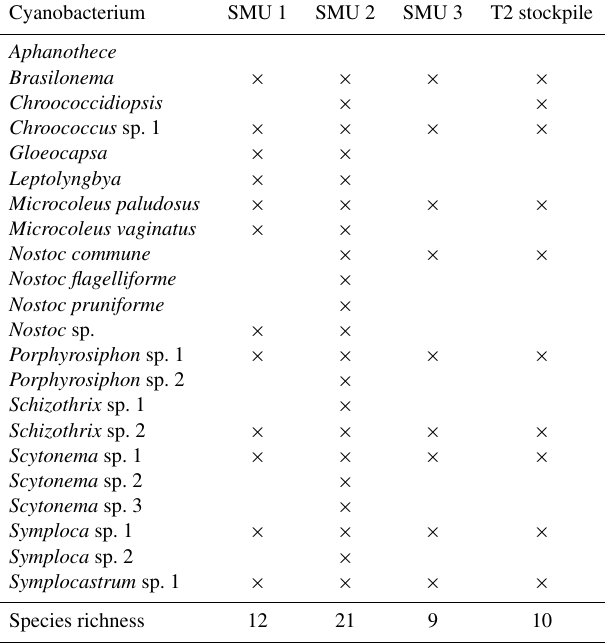
Table 5. Diversity across sites on a presence–absence basis for all seasons and the 2-year-old stockpile (T2). Different species at- tributed to a genus (i.e. sp. 1, 2, 3) have all been separated based on their morphological features and size but could not be positively